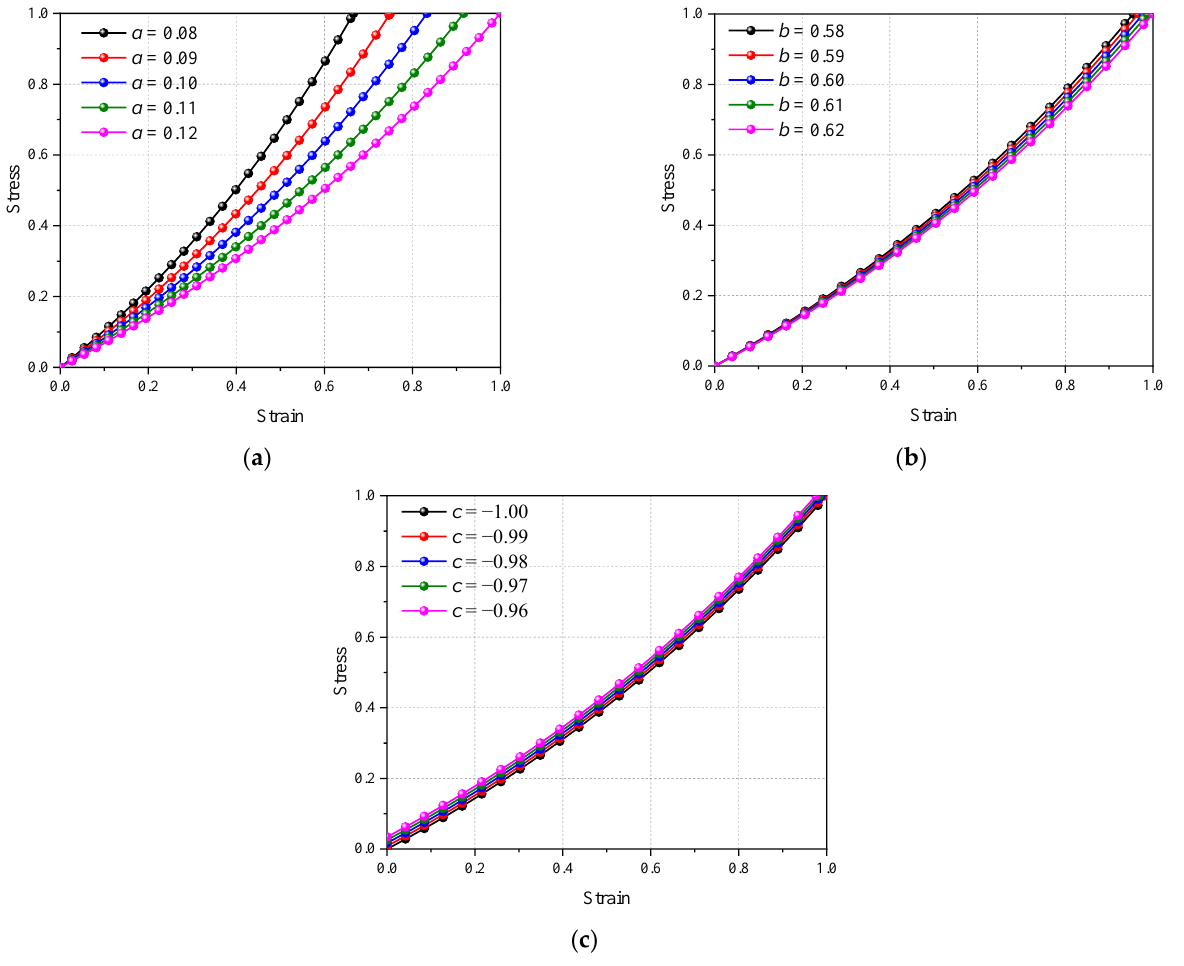
Figure 14. Influence of the fitting parameters after data normalization on the stress – strain curve. ( a ) Influence of a on stress – strain curve, ( b ) influence of b on stress – strain curve, and ( c ) influence of c on stress – strain curve.